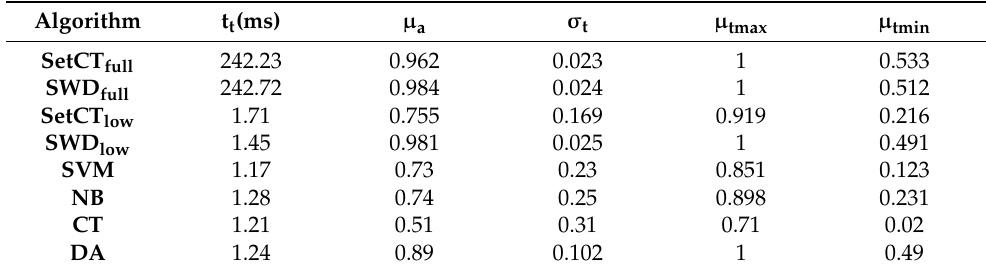
Table 7. The comparison of classification algorithms’ performance.